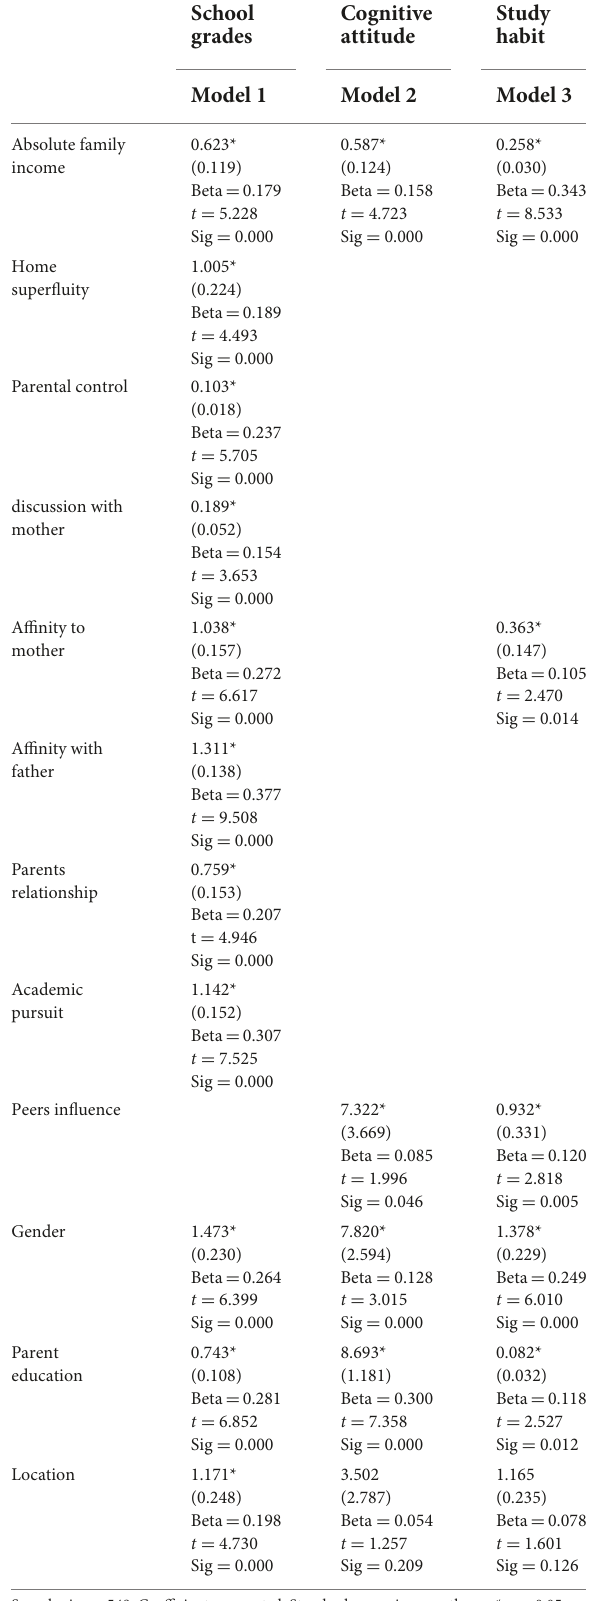
TABLE 5 Regression statistics of the mediating